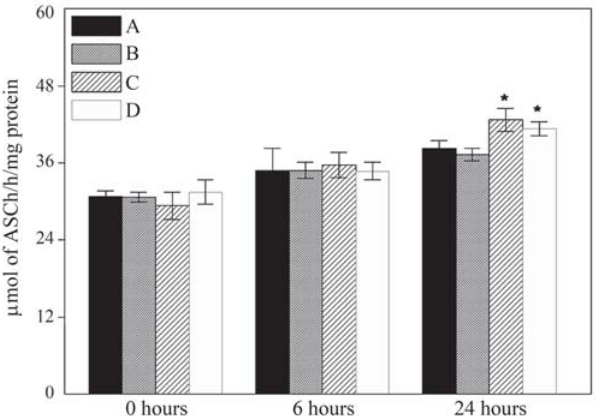
Fig. 3. AChE activity in supernatant of whole brain of silver